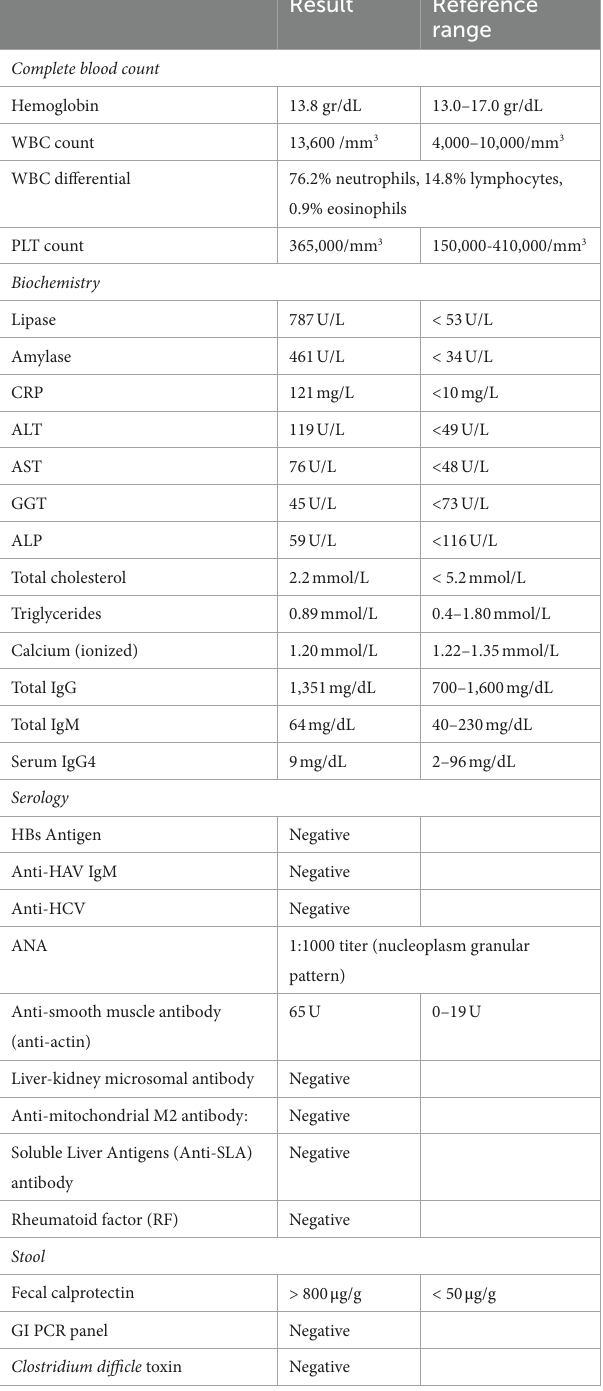
TABLE 1 Laboratory